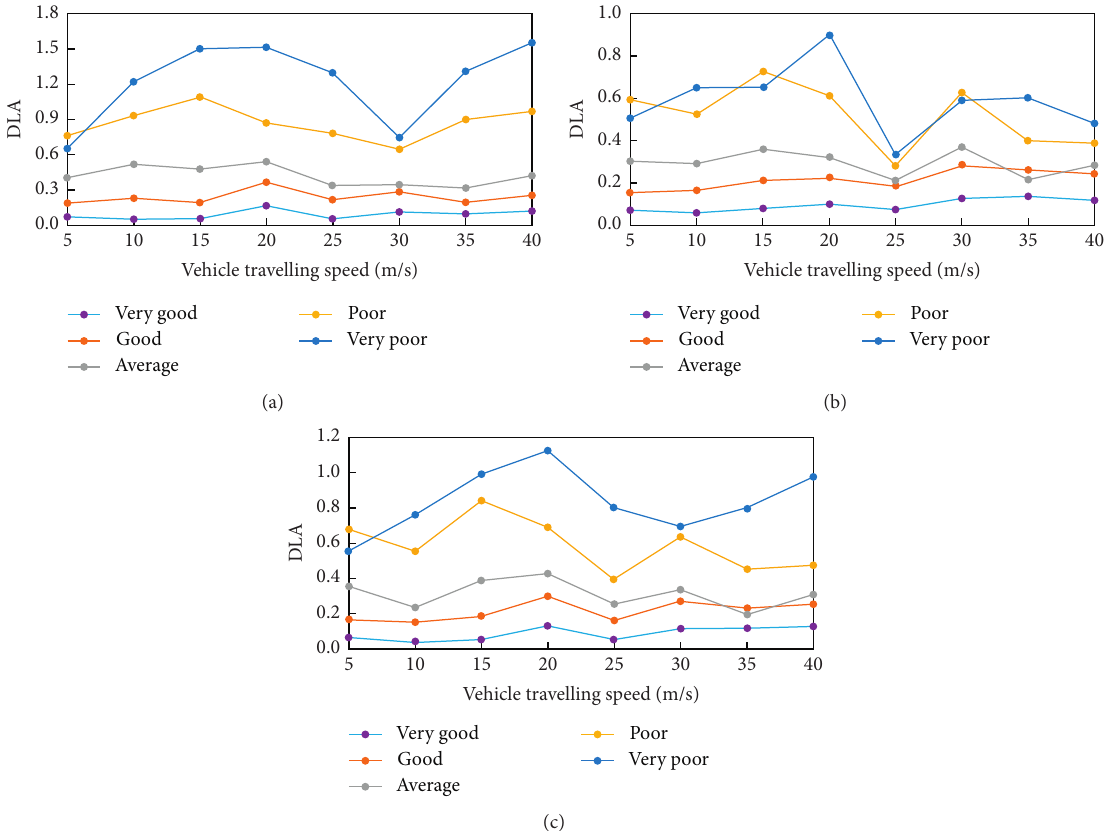
Figure 14: DLA for the vault section of the arch rib R : (a) DLA of the displacement; (b) DLA of the bending moment; (c) DLA of the axial